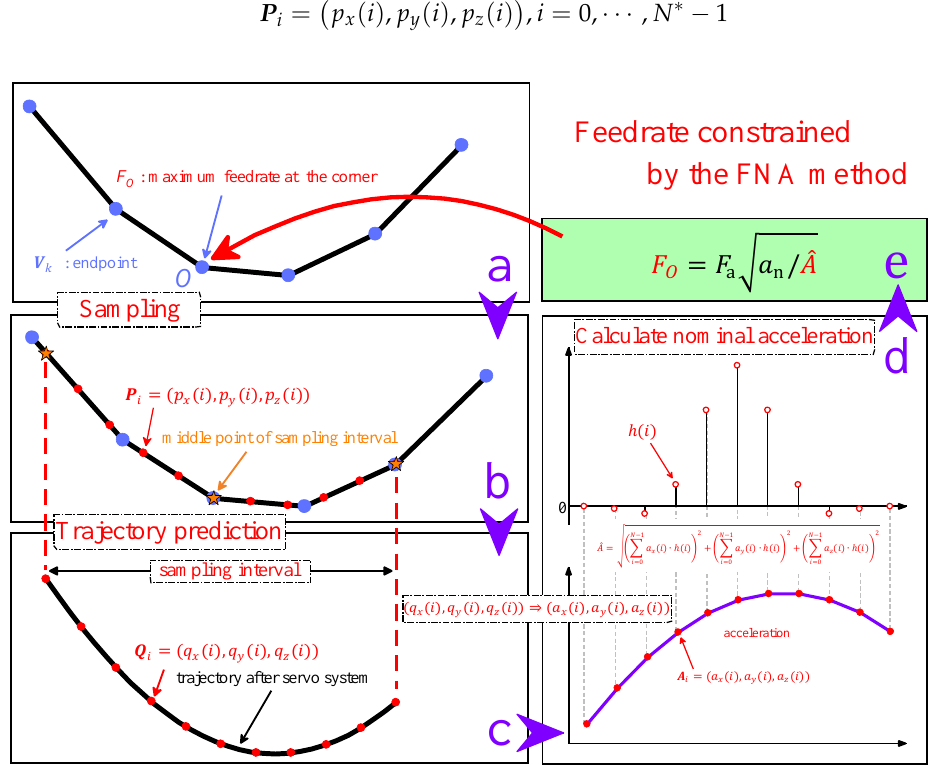
Figure 1. Flowchart of the FNA method.